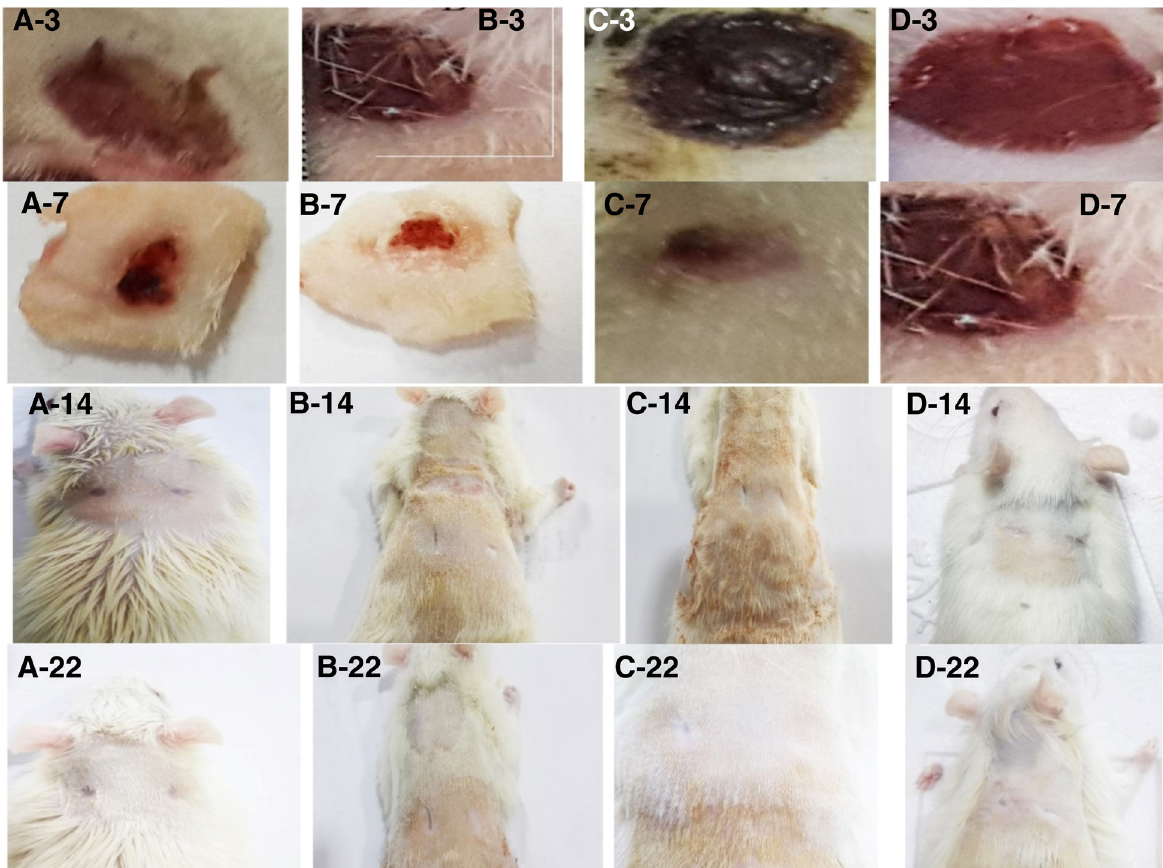
Fig. 9 The appearance of wound healing in different treated groups. a – d show the Satureja khuzistanica -treated, alginate hydrogel dressing-treated, alginate hydrogel/ Satureja khuzistanica dressing-treated, and control groups, respectively. The numbers indicate the number of days of